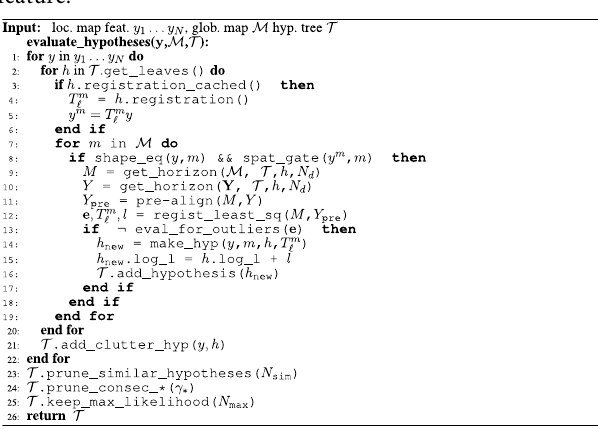
Frontiers in Robotics and AI |